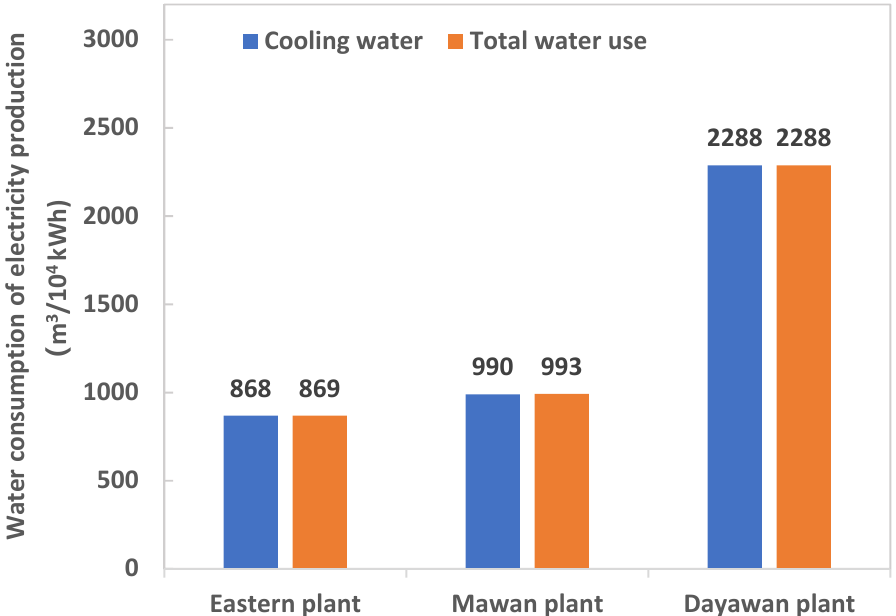
Figure 12. Water consumption of power plants using a closed cooling system.